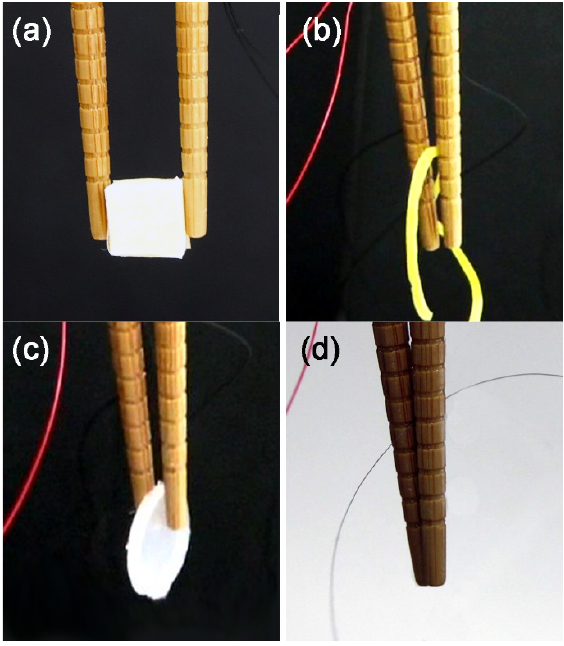
Figure 11. Pictures of the chopstick robot holding various objects: ( a ) a paper cube, ( b ) a rubber band, ( c ) a silicone piece, and ( d ) a strand of hair.